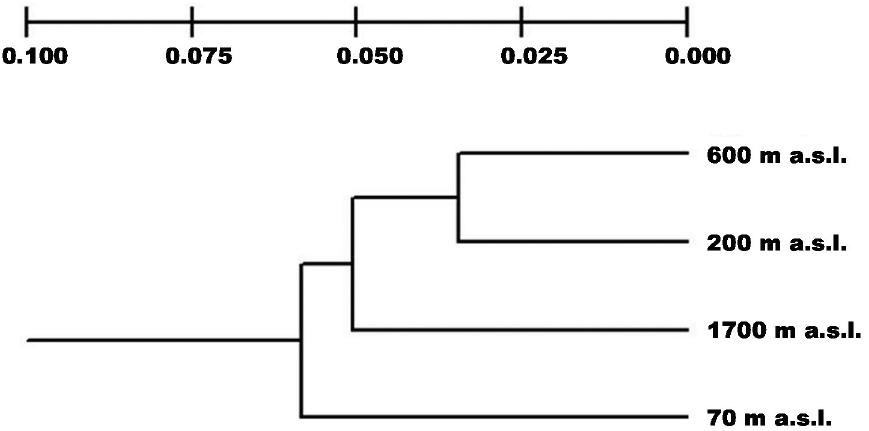
Figure 1. UPGMA diagram based on Nei’s genetic distances for P. mexicana on the Colipa River, Veracruz, Mexico.